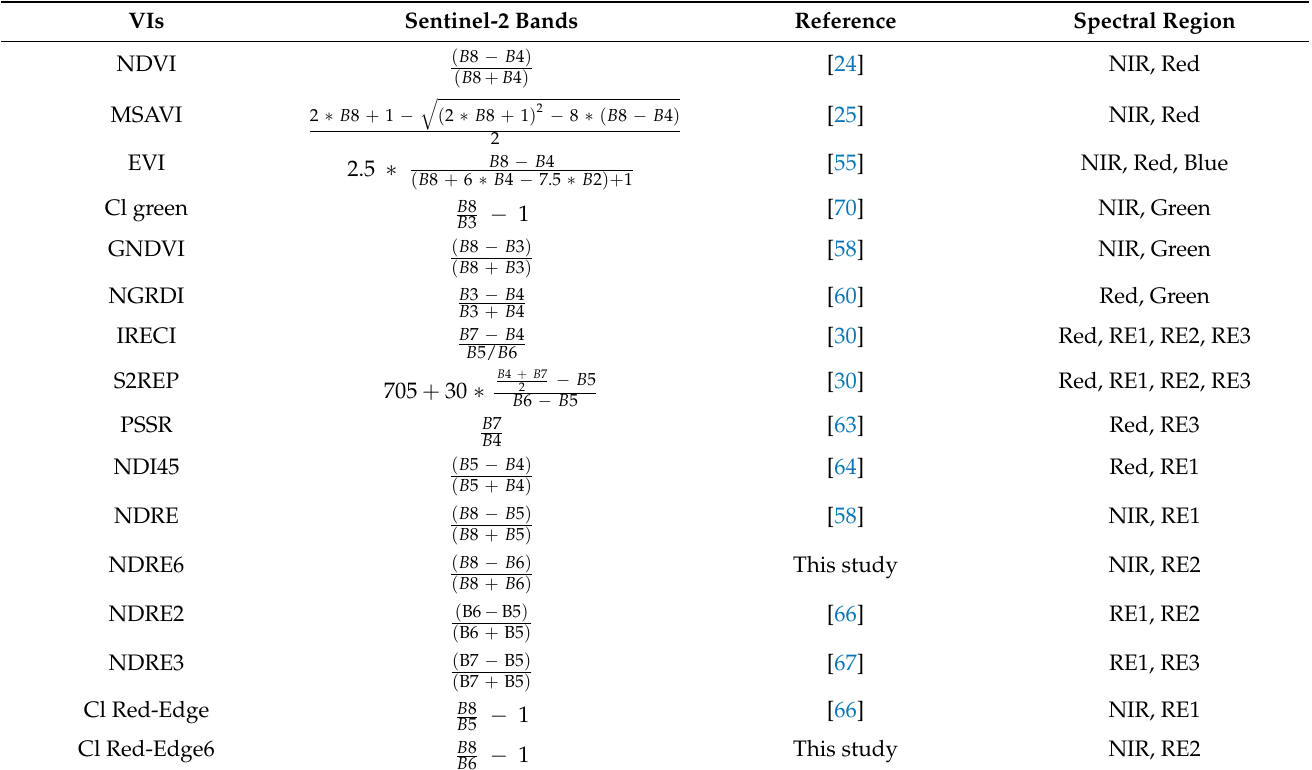
Table 3. Vegetation indices (VIs) calculations with Sentinel-2 bands and the spectral region of the bands. VIs Sentinel-2